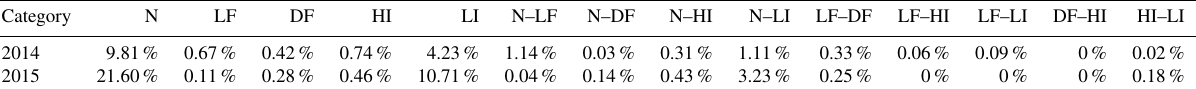
Table 2. Percentage of Mcc = 1 for each weather category.